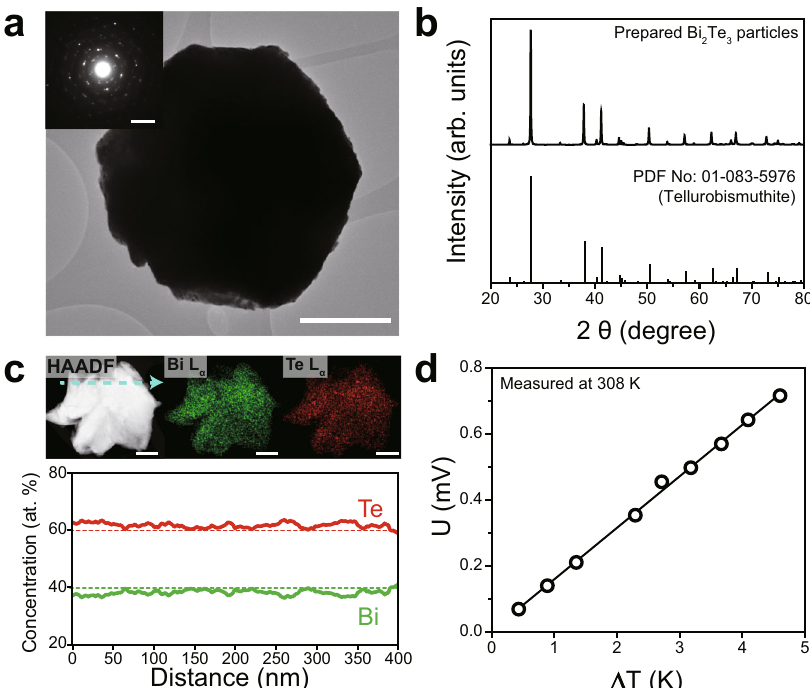
Fig. 2 Material characterization of the as-synthesized Bi 2 Te 3 particles. a Low-magni fi cation transmission electron microscopy (TEM) image of the synthesized Bi 2 Te 3 particle. Scale bar = 500 nm. Inset is the corresponding SAED pattern. Inset scale bar = 5 nm − 1 . b Powder XRD pattern of the synthesized Bi 2 Te 3 . Scan rate: 5° min − 1 . c HAADF-STEM image, EDS elemental mapping results, and STEM-EDS quanti fi cation results of dashed line. Green and red dashed lines denote the stoichiometric concentration of Bi and Te in Bi 2 Te 3 , respectively. Scale bar = 100 nm. d Measured electrical potential versus temperature gradient of the synthesized Bi 2 Te 3 at 308 K. The positive slope of U vs. Δ T indicates the negative sign of the relative Seebeck coef fi (propylbenzene: TTN r Aae UPO of 32,913, 74.1% ee ) within 48 h. Enantiopure oxygenated products were also obtained from the enzymatic conversion of tetralin (TTN r Aae UPO of 6361, >99% ee ), cyclohexane (TTN r Aae UPO of 10,559), and cis - β -methylstyrene (TTN r Aae UPO of 18,095, >99% ee ). Again, control experiments revealed that thermoelectrocatalysis (TEC) was essential to supply the